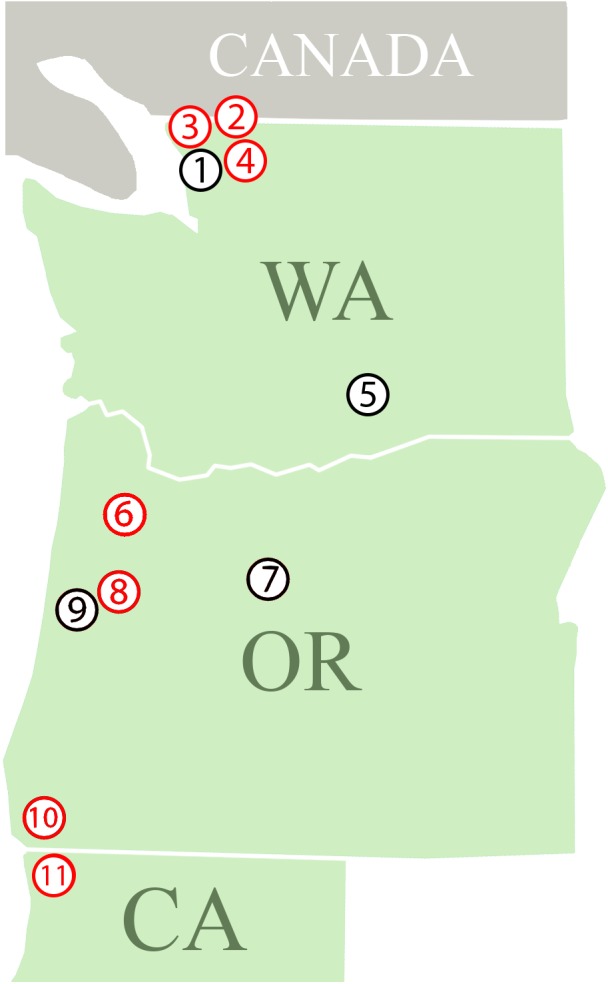
Field locations where Pratylenchus penetrans populations were collected. (1–11 = locations; 1: Lynden; (a–f) – Raspberry, 2: Sumas – Raspberry, 3: Custer – Raspberry, 4: Everson – Raspberry, 5: Prosser; (a) Cherry, (b) Apple, (c) Mint, 6: Dayton; (a) Apple, (b) Pear, (c) Strawberry, 7: Madras – Mint, 8: Corvallis; (a) Raspberry, (b,c) – Cherry, 9: Philomath – Mint, 10: Brookings; (a–e) – Lily, (f–h) – Clover, 11: Smith River; (a,b) – Lily, (c–e) – Clover. Red: At least one population from this location is infected with Wolbachia wPpe, Black: Locations with Wolbachia wPpe-uninfected populations.